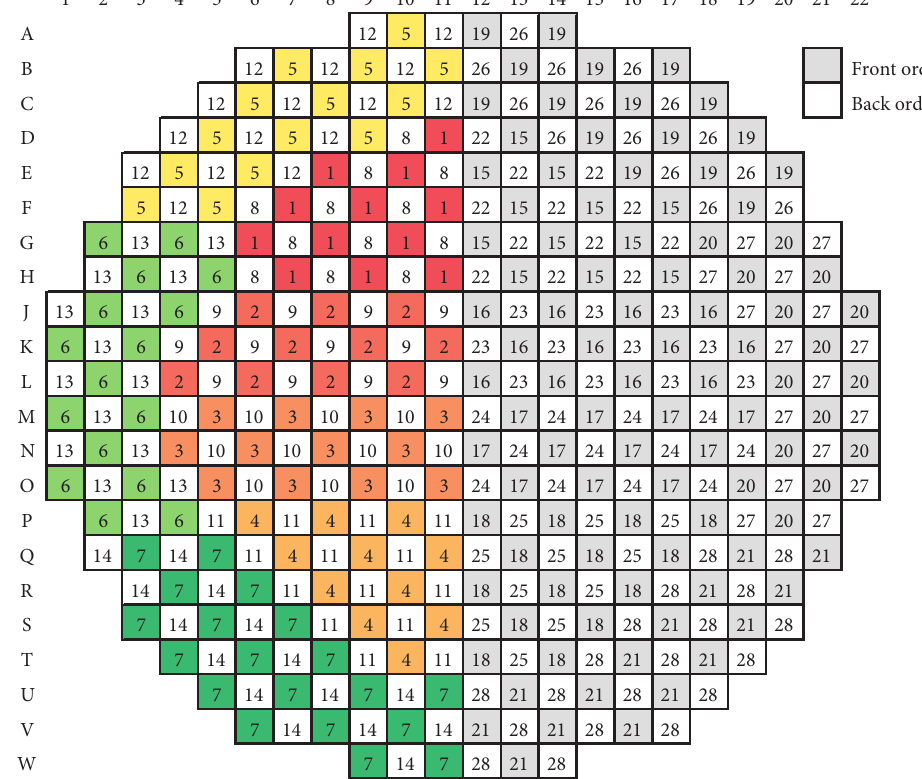
Figure 5: Neutronic radial channel nodalization and mapping to thermal-hydraulic channels (reflector not shown) [3].